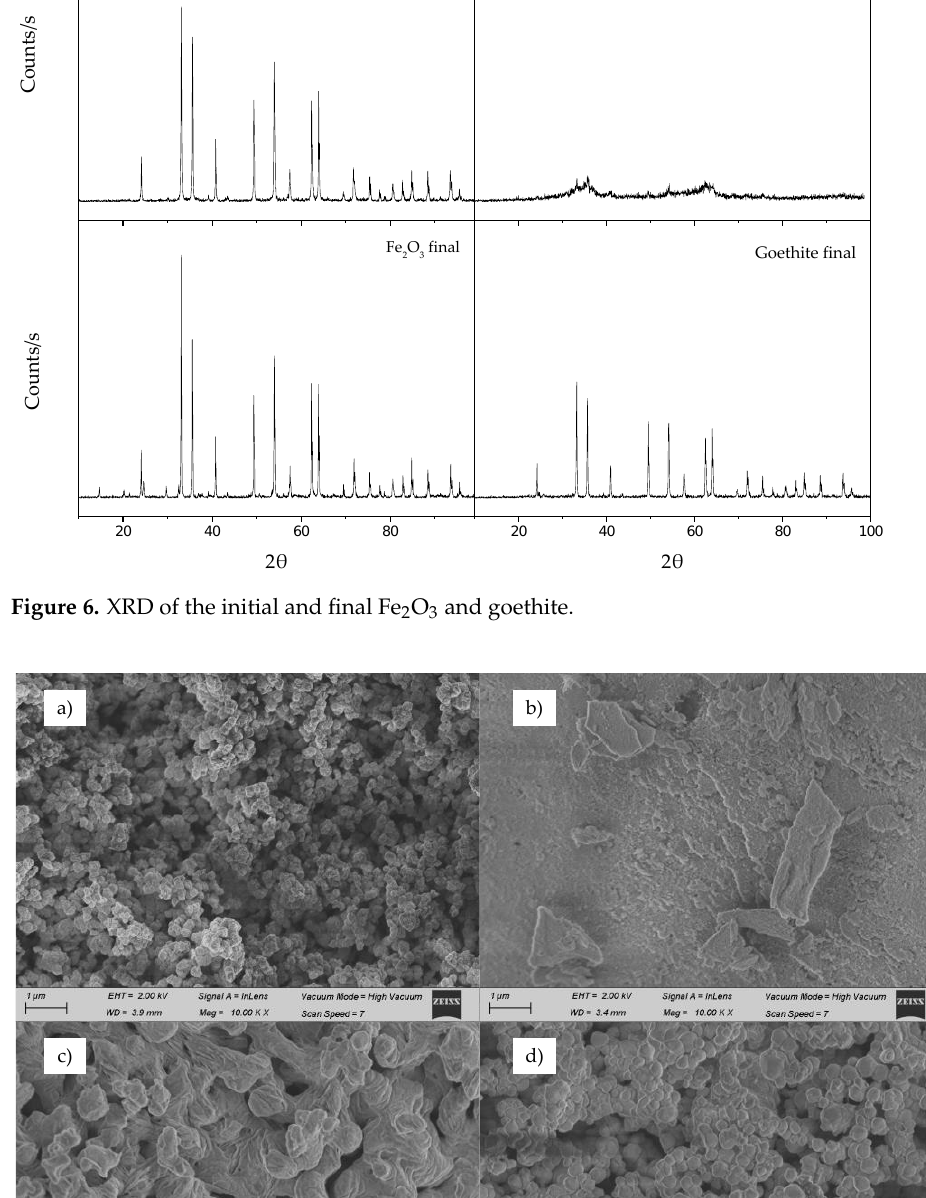
Figure 8. EDX analysis of initial ( a , b ) and final ( c , d ) Fe 2 O 3 and goethite catalysts, respectively. Table 1. EDX composition of the initial and final catalysts. Fe 2 O 3 Initial/Final